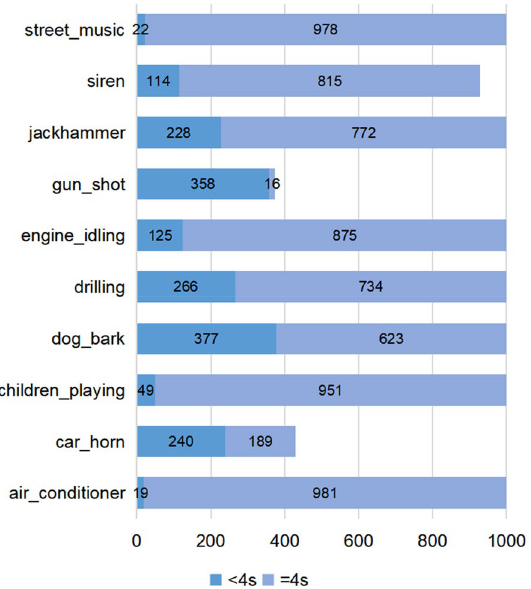
Figure 6. UrbanSound8K dataset (Dark blue represents sample < 4 s, light blue represents sample > 4 s).